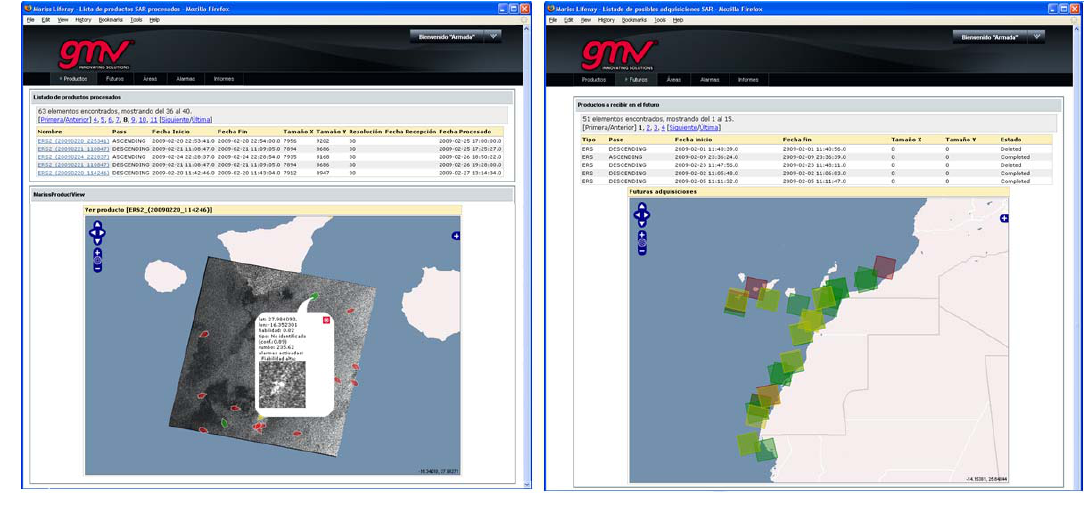
Figure 9. Web GIS support for SIMONS with single products and future products